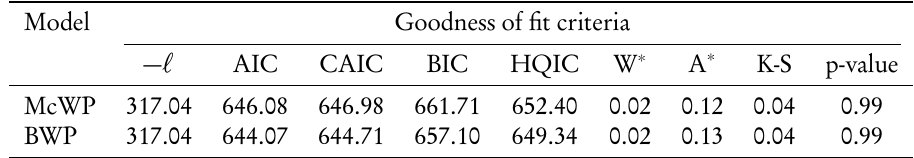
The AIC, CAIC, HQIC, BIC, W ∗ , A ∗ , K-S statistics and p-value for failure time